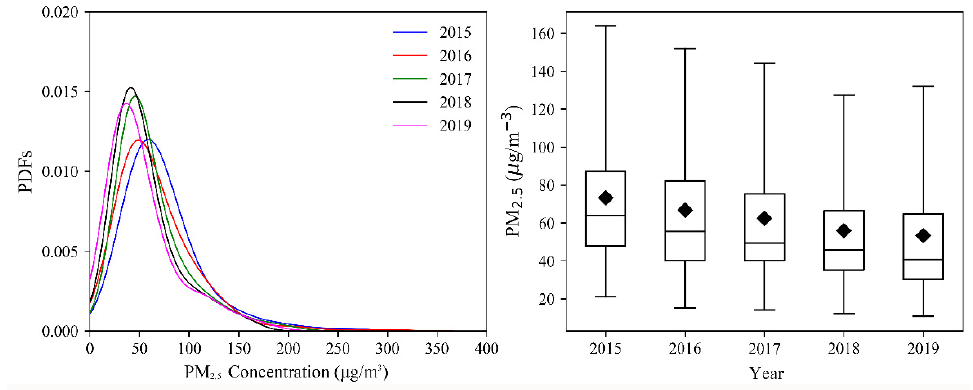
Figure 2. Probability density function (PDFs) and annual concentration of PM 2.5 from 2015 to 2019.